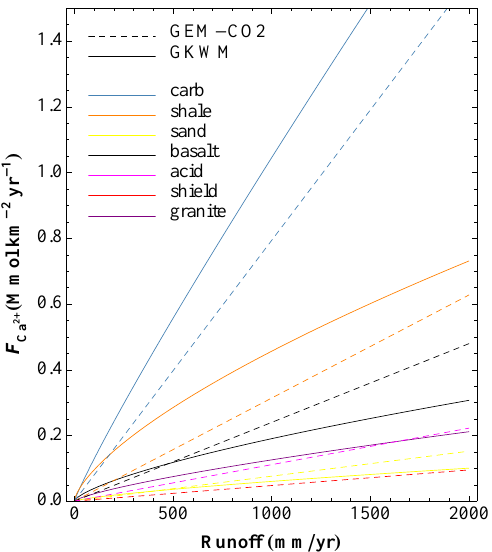
Fig. 16. Run-off dependence of weathering for different rock types, Fig. 16. Runoff dependence of weathering for different rock types, in GEM-CO2 (dashed lines) and in GEM-CO2 (dashed lines) and GKWM (solid lines) (Eq. GKWM (solid lines) (Eq. 15).